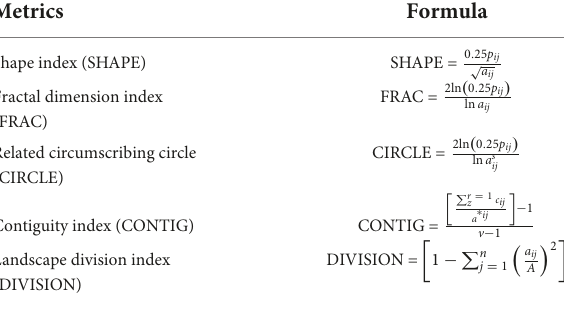
TABLE 3 Formulas of the landscape metrics used in this